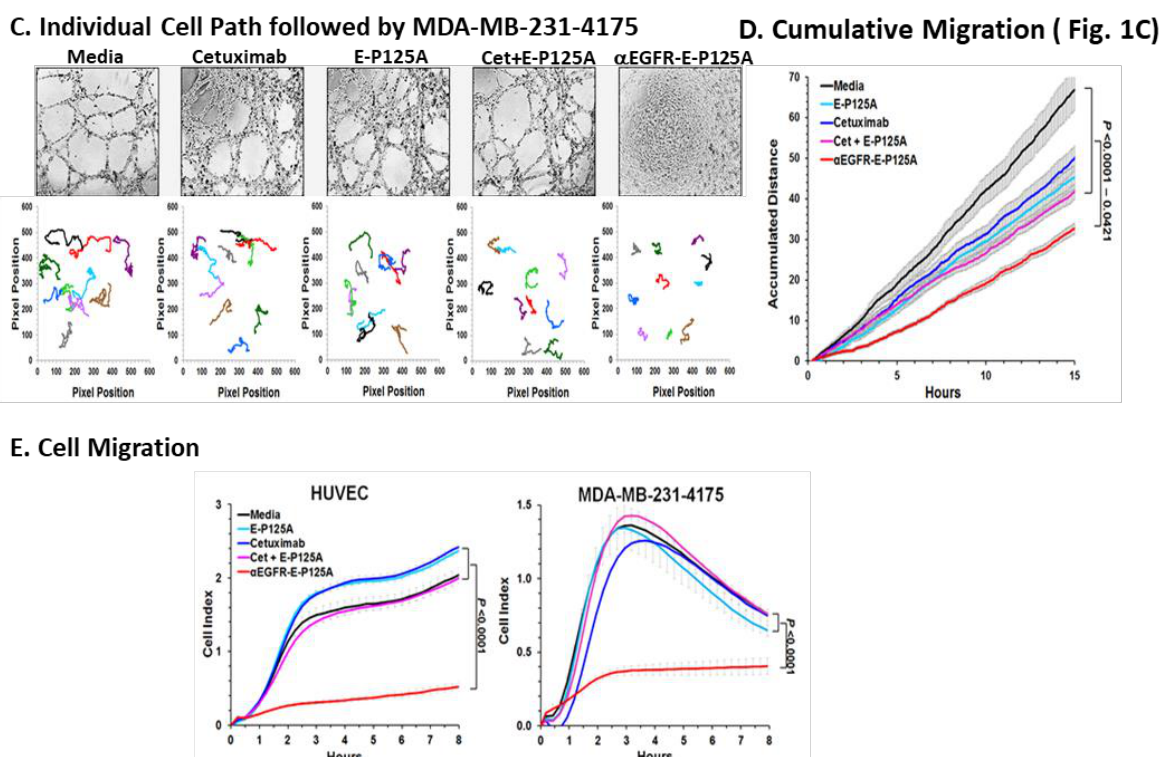
Figure 1. α EGFR-E-P125A: Effects on angiogenesis and VM. ( A ) Schematic diagram of antibody–endostatin fusion proteins ( α EGFR-E-P125A and Fc-E-P125A): Human endostatin-P125A domains are shown in orange, and the proline to